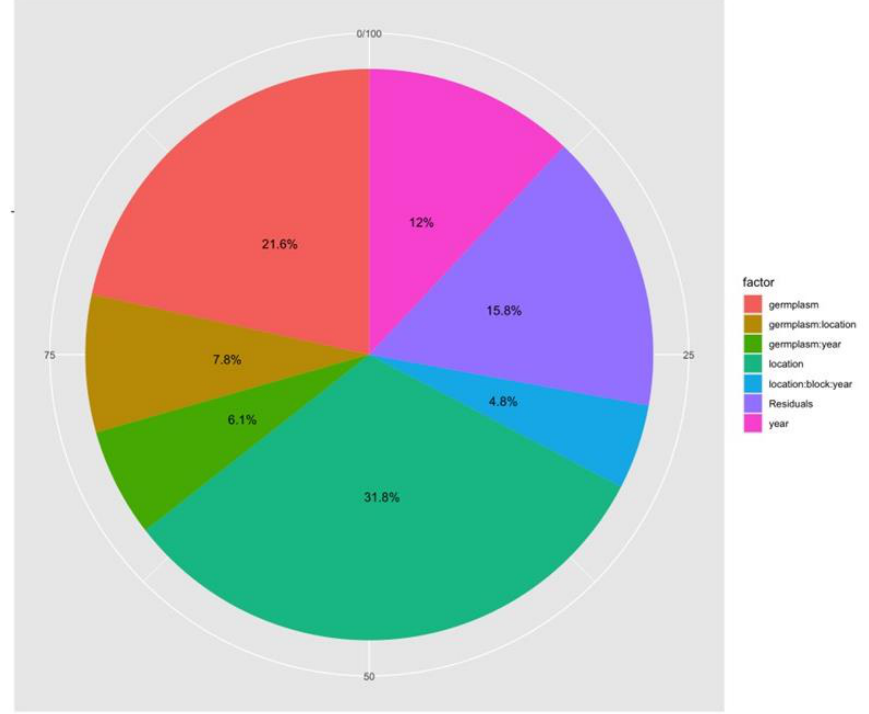
Figure 3. Yield error variance explained by each term in an AMMI model data across all genotypes and environments as analyzed using an R package, PPBstats 0.26 based on a Bayesian model [14].